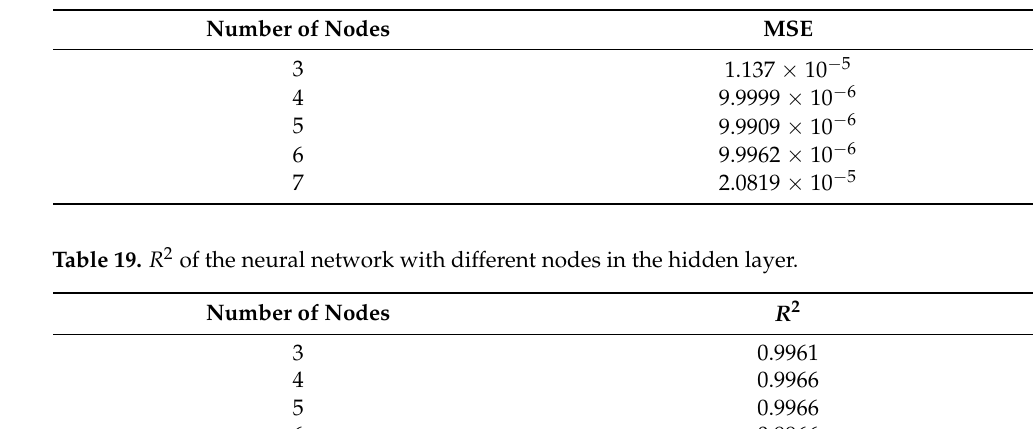
Table 18. MSE of the neural network with different nodes in the hidden layer.